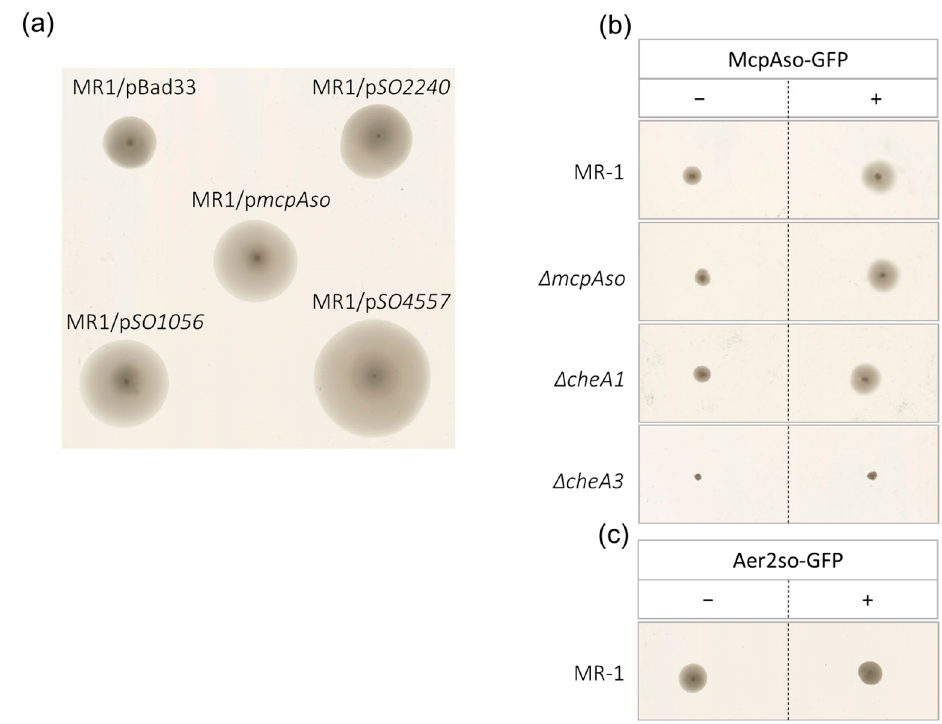
Figure 5. McpAso overproduction increases S. oneidensis swimming. ( a ) Wild type S. oneidensis strain (MR1) containing a vector (pBad33) or a plasmid allowing the overproduction of McpAso or other MCPs (SO_4557, SO_1056, and SO_2240) were grown on LB plates and stabbed on minimum medium soft agar plates with 0.2% arabinose. ( b ) Wild type S. oneidensis strain (MR1) or mutant derivatives ( Δ mcpAso , Δ cheA1, and Δ cheA3 ) containing either the empty vector p33 Tac (-) or a plasmid allowing the overproduction of McpAso-GFP (+) were grown overnight on LB plates and stabbed on minimum medium soft agar plates with 1mM IPTG. ( c ) Alike ( b ), except with respect to the wild type S. oneidensis strain (MR1) containing p M2-GFP (+) allowing the overproduction of Aer2so-GFP. Plates were incubated at 28 °C for four days. Results shown on the plates are representative of at least three independent experiments.